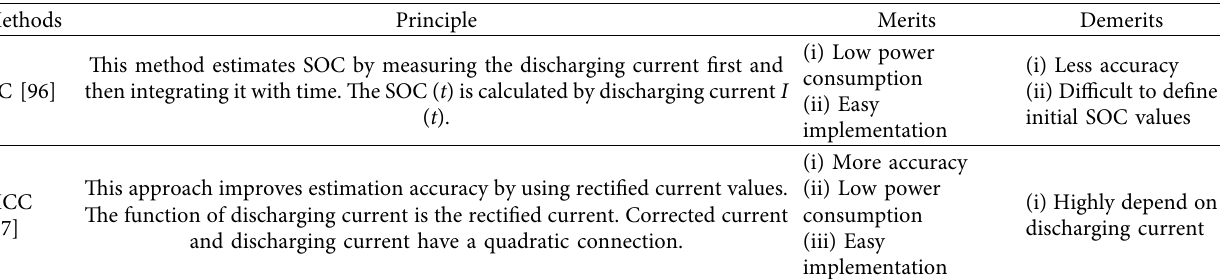
Table 4: Comparison of bookkeeping method of SOC